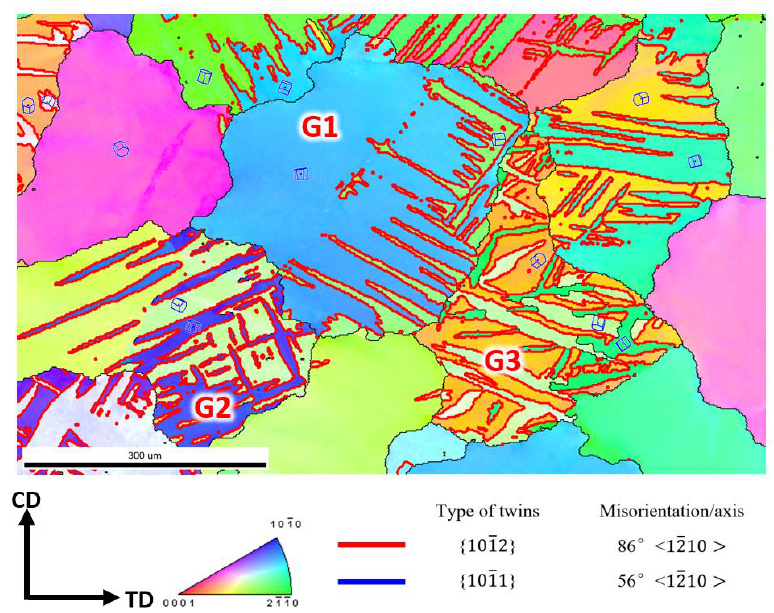
Figure 16. The IPF + GB map of the P3 specimen. G1 is the grain the matrix was almost covered by the twin in blue. G2 is the grain which matrix is yellow-green and twinning is blue. G3 is the matrix in yellow with two twin variants.